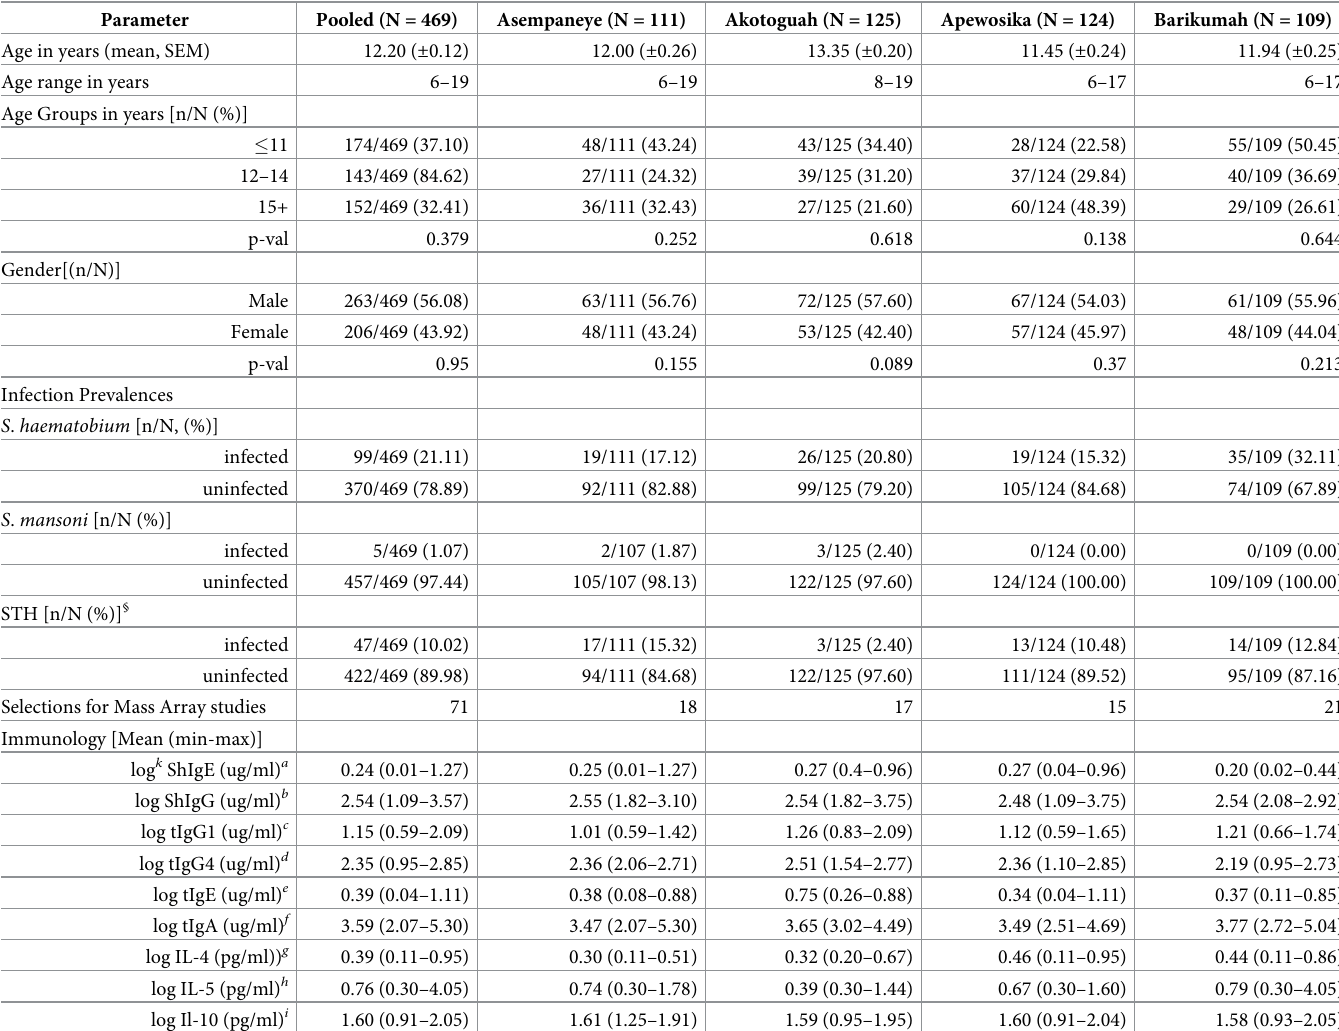
Table 1. Characteristics of study